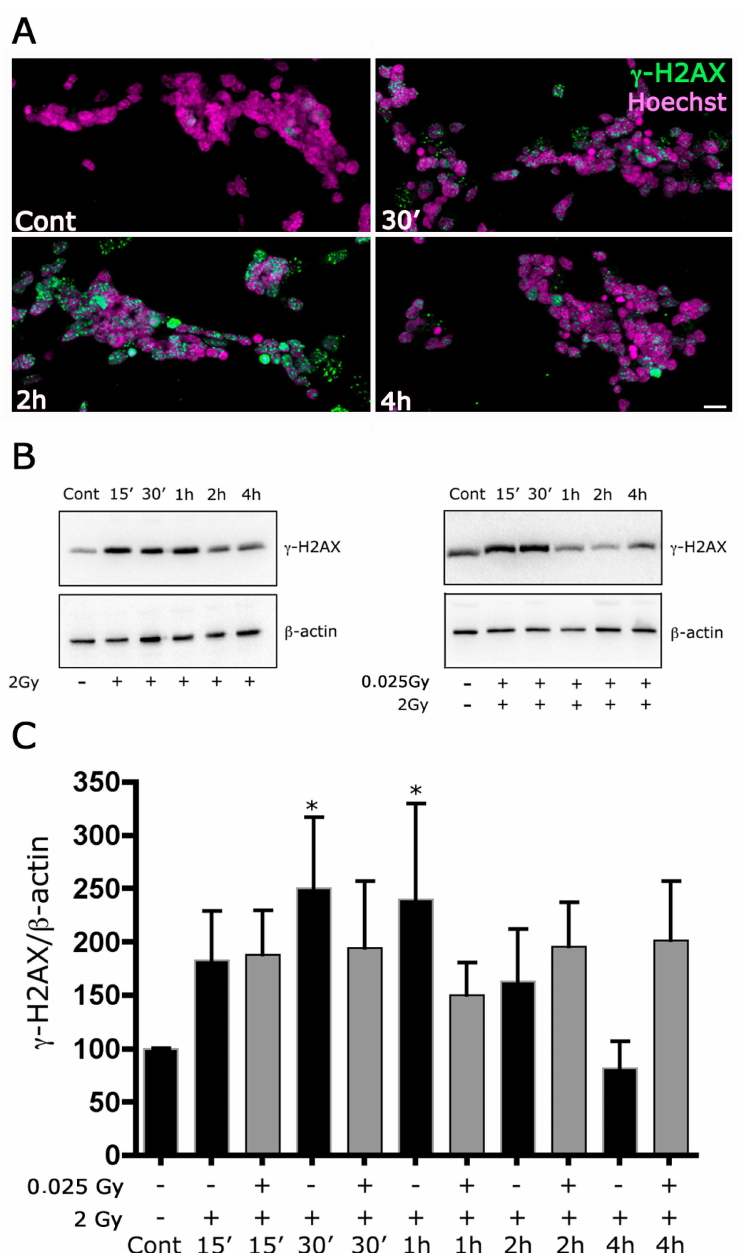
Figure 3. The priming dose reduces the expression of γ -H2AX induced by irradiation with 2 Gy. ( A ) Retinal cultures were fixed after 30’, 2 h or 4 h from the 2 Gy irradiation and immunolabeled with anti-mouse monoclonal anti-phospho–histone H2AX antibody and revealed with 488 Alexafluor conjugate anti-mouse secondary antibody. The cultures were counterstained with Hoechst 33258. Scale bar = 20 µ m. ( B ) Whole-cell lysates were prepared from retinal cultures. Equal amounts of total protein from each lysate were resolved on 15% SDS-PAGE and transferred to nitrocellulose membranes. Membranes were probed with anti-mouse monoclonal anti-phospho–histone H2AX antibody. β -actin levels were used as a control of protein loading. Blots are representative of five independent experiments. ( C ) Bar graphs represent the mean ± SEM from five independent experiments as in ( B ). * p < 0.05 versus control, Wilcoxon signed-rank